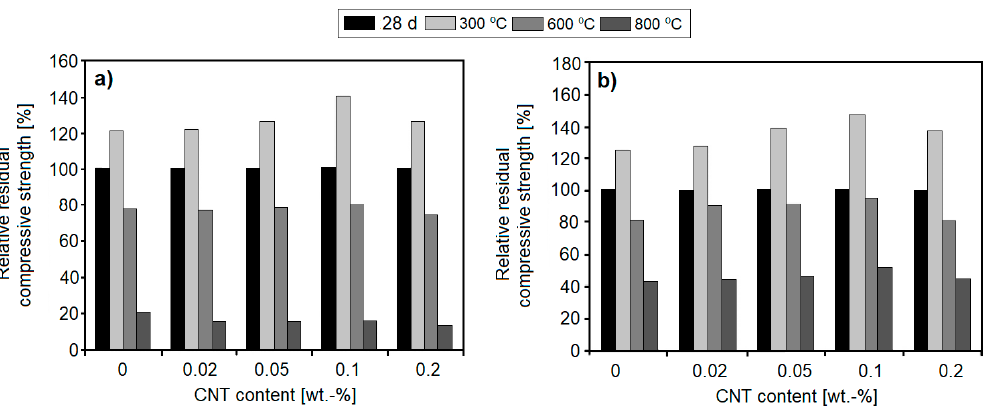
Figure 7. The effect of carbon nanotubes (CNT) content on the relative residual compressive strength of cement pastes containing 100 wt. % of ordinary Portland cement (OPC) ( a ) and 70 wt. % of OPC and 30 wt. % of Homra ( b ) after firing. Reproduced with permission from [59]. Copyright Elsevier, 2015.